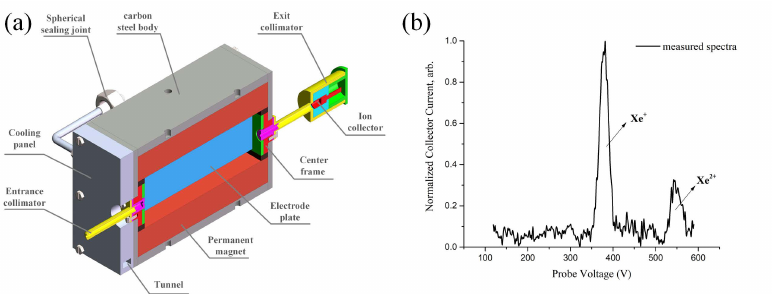
Figure 13. ( a ) Schematic of the E × B probe with an active cooling system. ( b ) The typical spectra measured by the E × B probe for the LIPS-200 ion thruster [49].